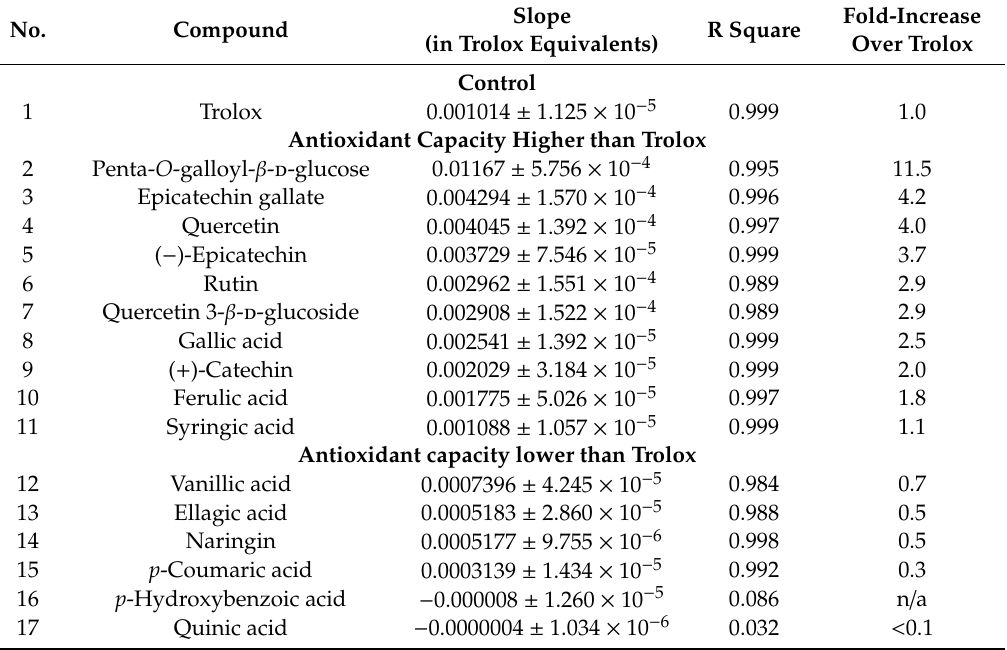
Table 1. Antioxidant activities of phenolic compounds in black